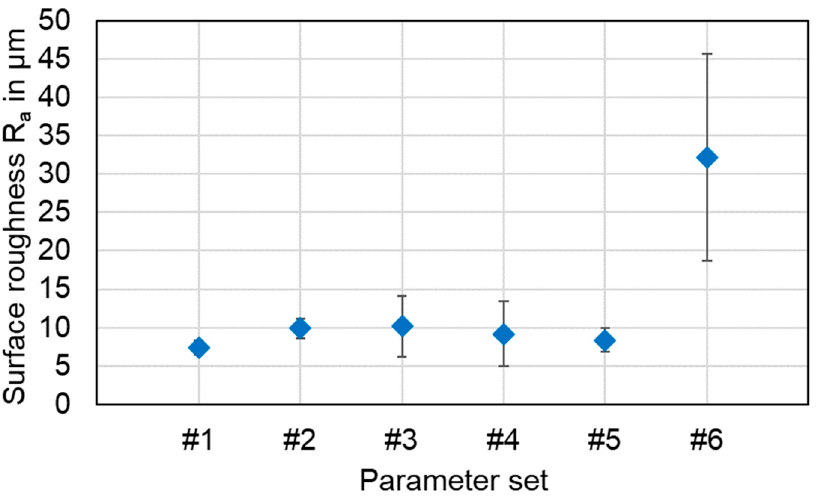
Figure 19. Seam surface roughness evaluated over the entire seam area on copper for parameter sets #1–#6 (see Table 5, n = 6).